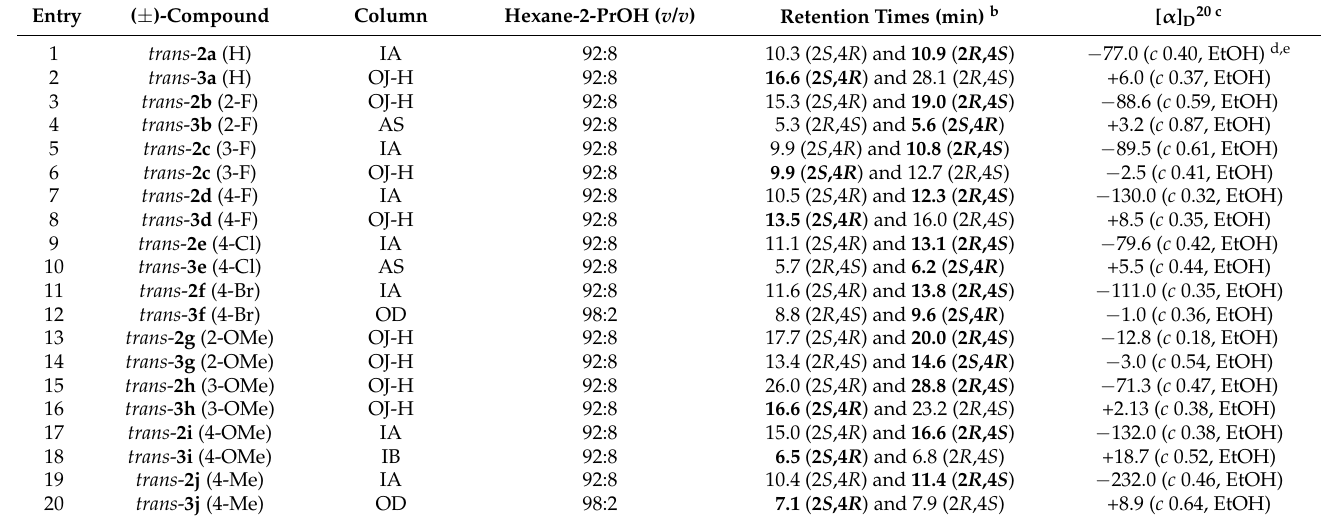
Table 6. HPLC conditions and specific optical rotation values of optically active compounds a